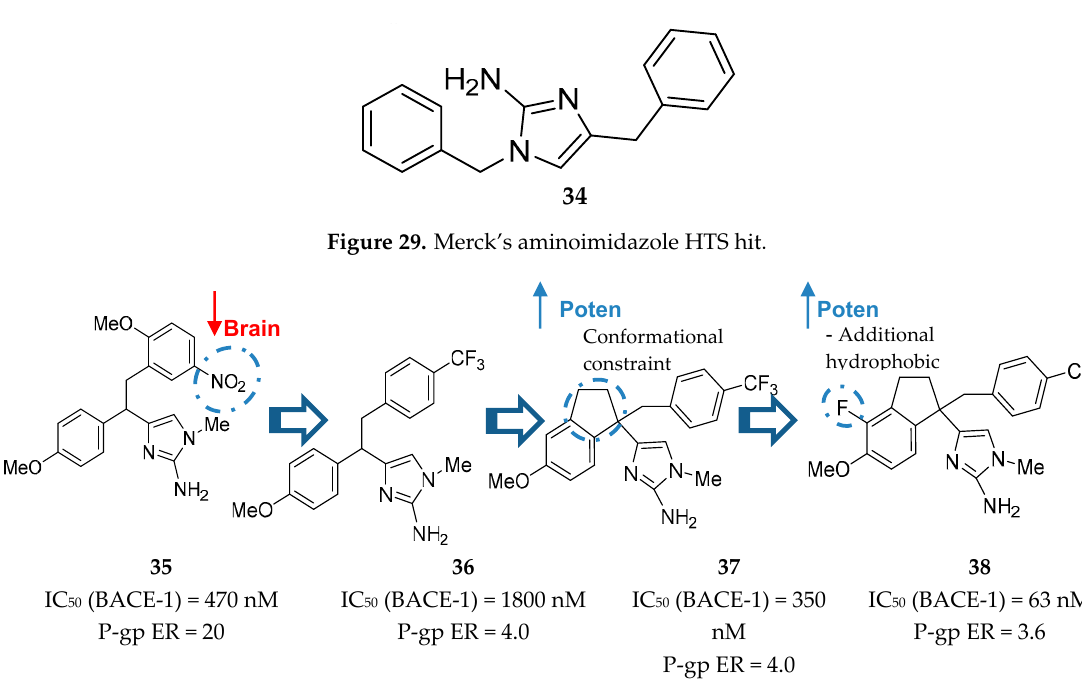
Figure 30. Merck’s aminoimidazole-based inhibitors.